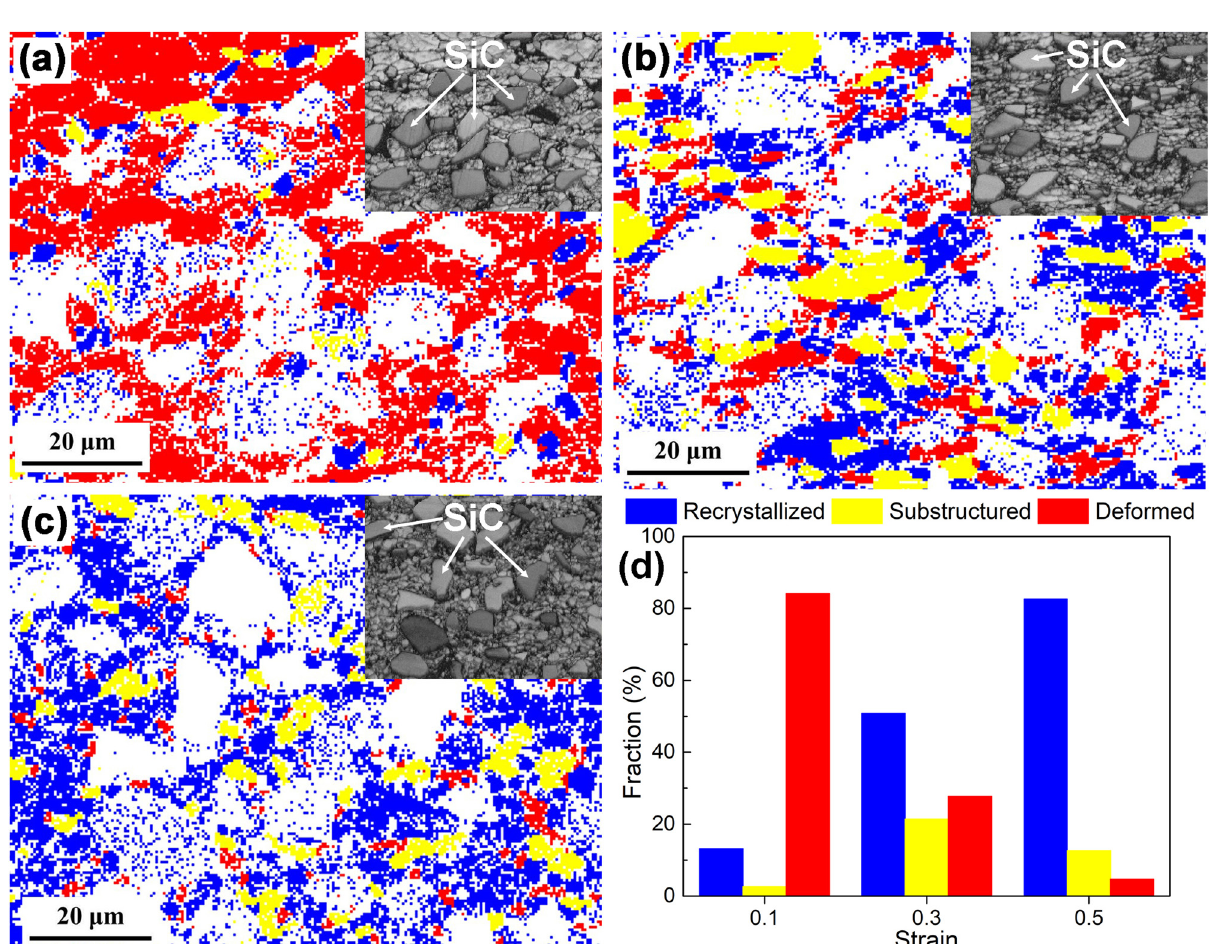
Figure 15: EBSD maps of HAMCs at 500°C with a strain rate of 1 s − 1 and strains of ( a ) 0.1, ( b ) 0.3, ( c ) 0.5, and ( d ) fractions of three types of microstructures in ( a – c )